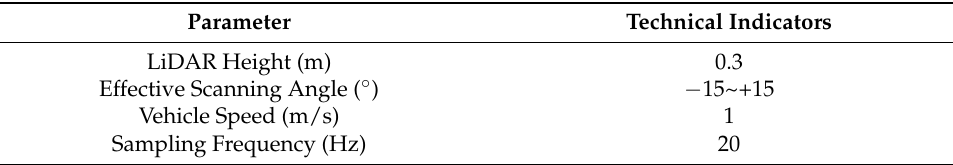
Figure 12. ROS Autonomous Navigation Vehicle. Table 1. Specific parameters of the experiment.